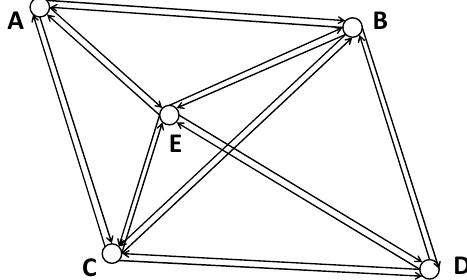
Figure 1. Sketch of a map of an air traffic network.